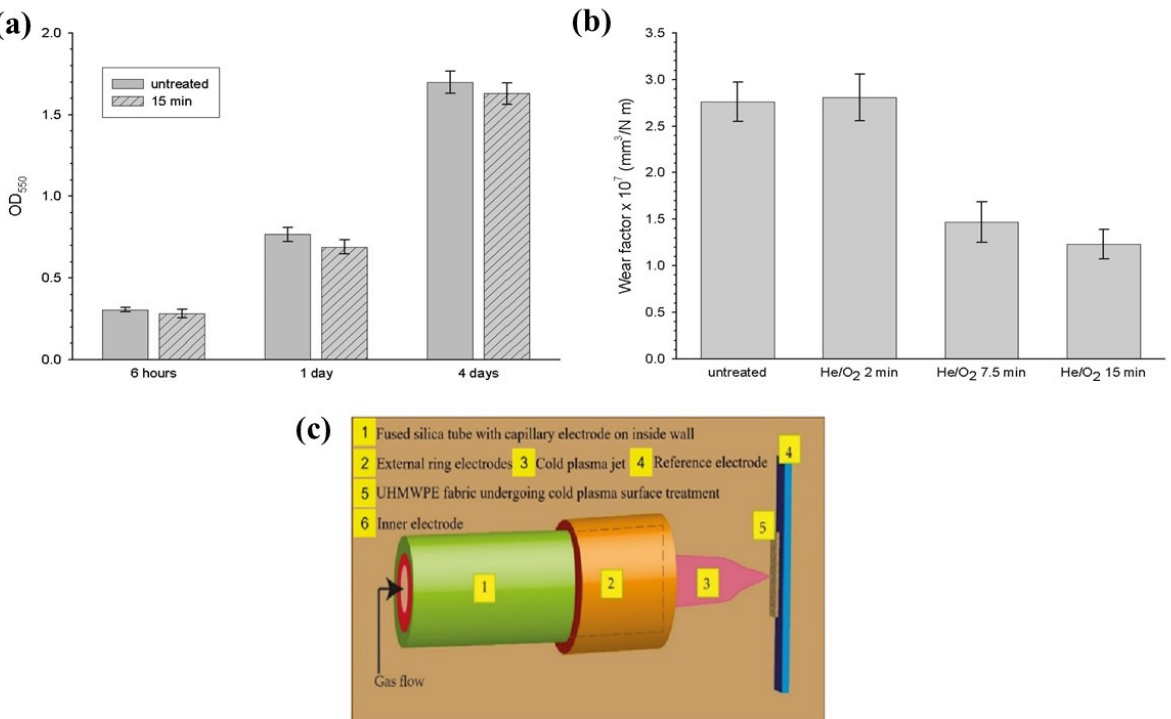
Figure 6. ( a ) Wear factors of untreated and treated UHMWPE after cold plasma treatment, reprinted with permission from [89]; ( b ) osteoblast cell adhesion to untreated and cold plasma treated UHMWPE, reprinted with permission from [89]; ( c ) a schematic diagram of cold atmospheric plasma.